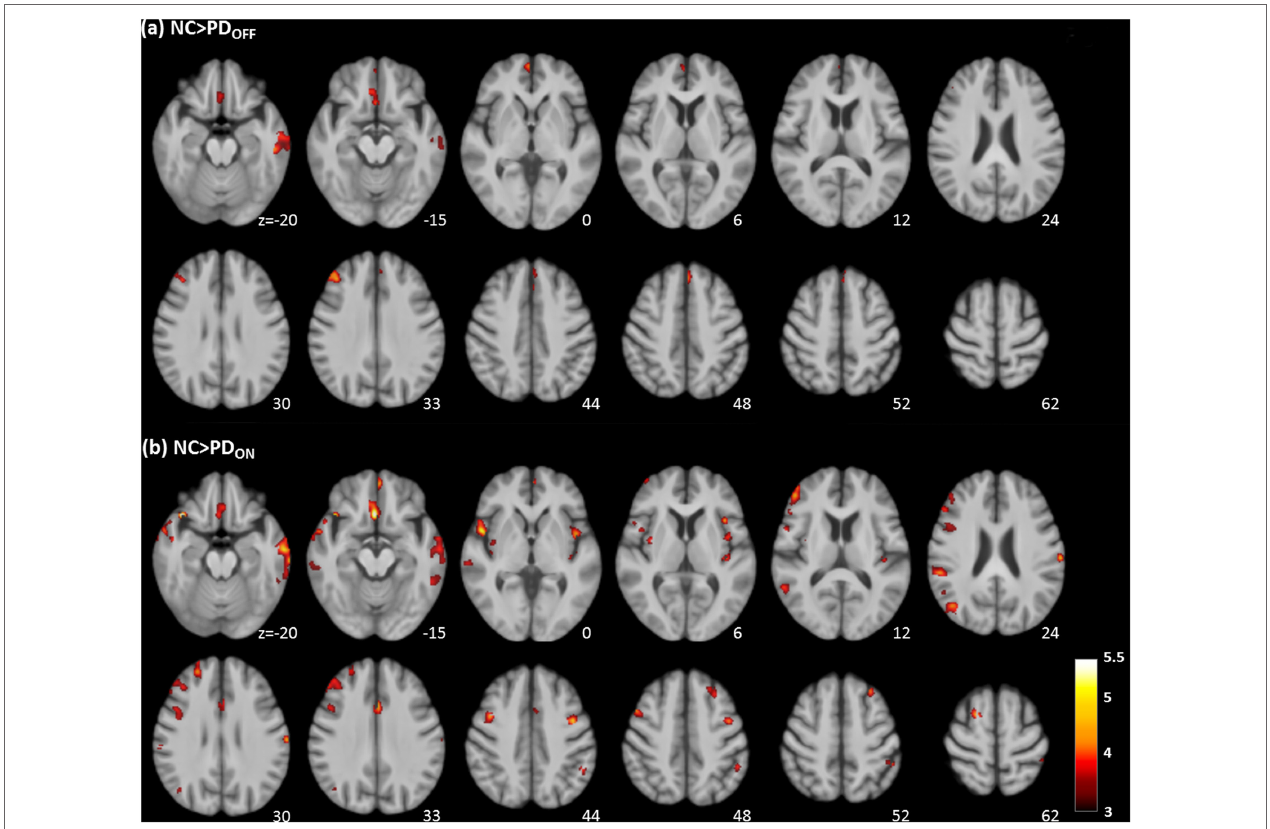
FigUre 2 | Regions with significantly decreased absolute cerebral blood flow in Parkinson’s disease (PD) patients in the OFF (a) and ON (B) states compared to healthy controls (cluster level statistics, P < 0.05, family-wise error corrected). The color bar indicates the T